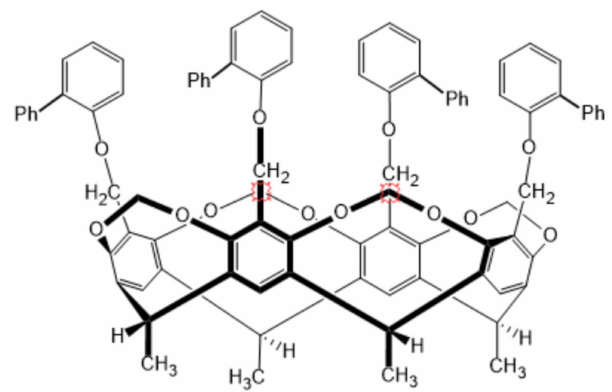
Figure 1. Structural formula of the studied cavitand ( 1